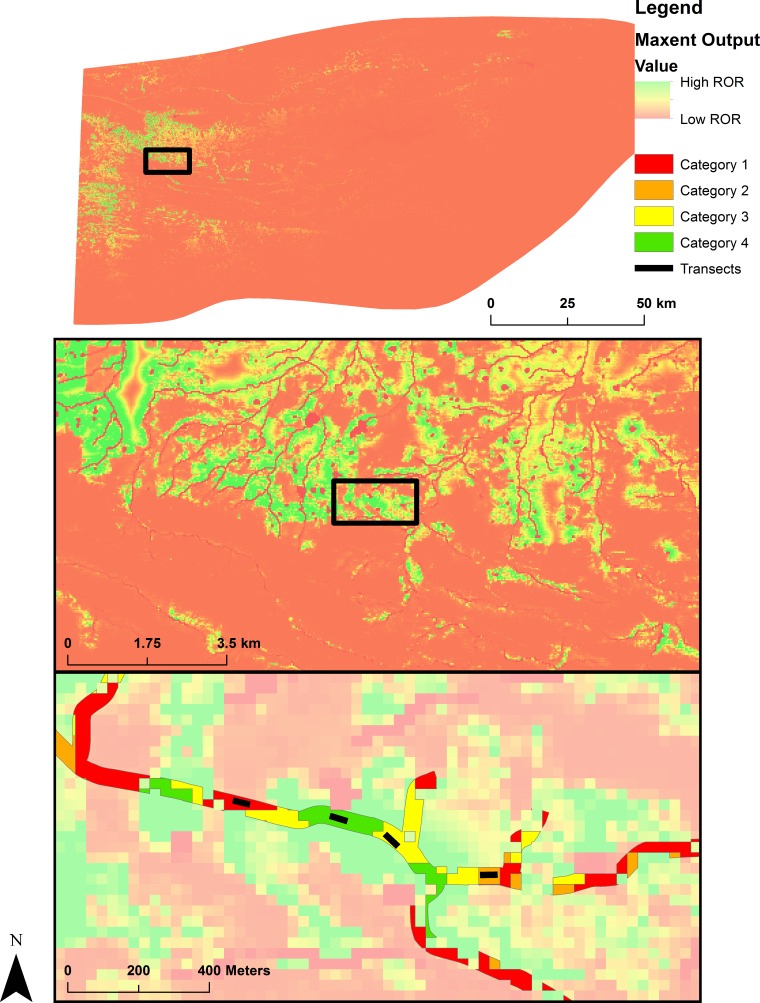
Map of ground validation.Map representing the sampling scheme based on the predictions from a Maxent analysis of two primary burrowing crayfish species (Fallicambarus harpi and Procambarus reimeri) in western Arkansas in the spring of 2015. Each color represents a relative occurrence category upon which the field validation sampling procedure was based. The black lines in the lower graphic depict 50-m transects used to assess presence or absence of the target species at each site. The linear, focused colors in the bottom graphic represent the accessible polygons in which the transect sampling was carried out.